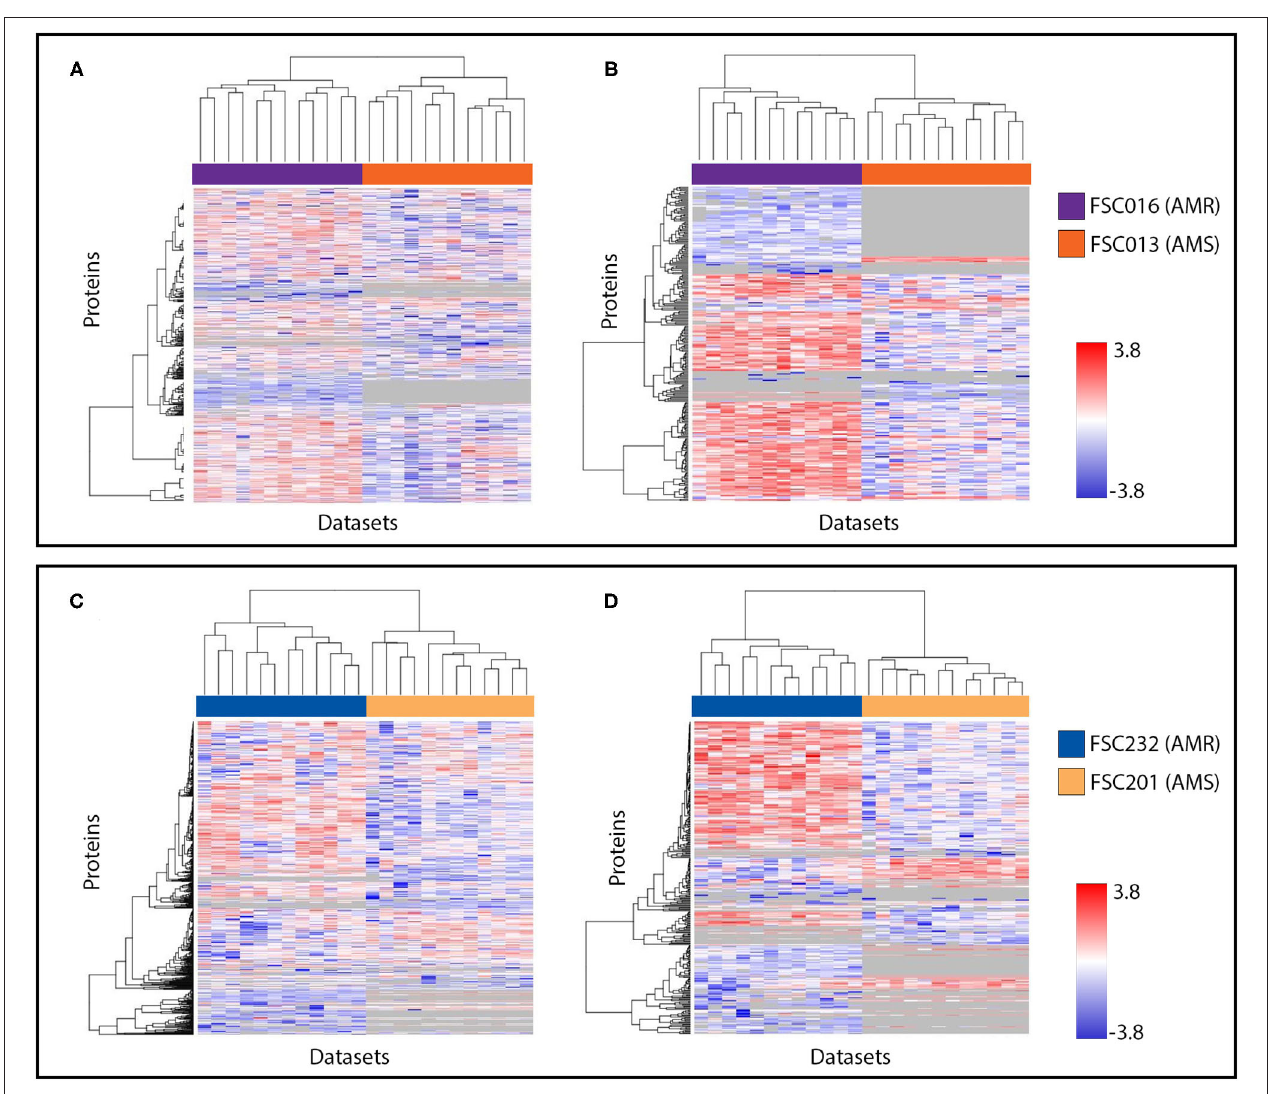
FIGURE 2 | Visualization of protein expression patterns reveals bidirectional protein expression changes in both F. tularensis strain pairs. (A,B) are data from FSC016/FSC013; (C,D) are data from FSC232/FSC201. (A,C) include all proteins observed in our analyses of both strain pairs at the early time point. (B,D) include the subset of proteins found to be significantly differentially expressed between AMR and AMS strains, as well as those found to be present/absent in this comparison. Proteins are represented in individual rows along the y-axis, and datasets are represented as individual columns along the x-axis. In all heat maps, hierarchical clustering was used to group proteins with similar expression trends. Expression levels are shown on a scale from blue (low) to red (high). Gray indicates the protein was not observed in a dataset.